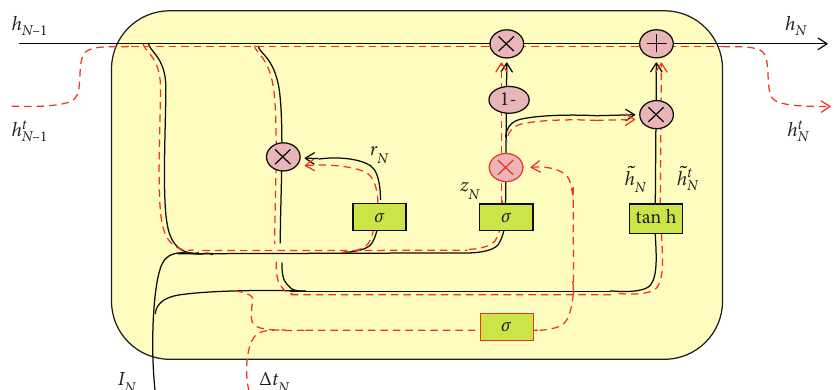
Figure 3: The structure of our proposed time-GRU. In addition to the network links of normal GRU (shown in black lines), we design network links and a new gate to capture time interval information (shown in red-dotted